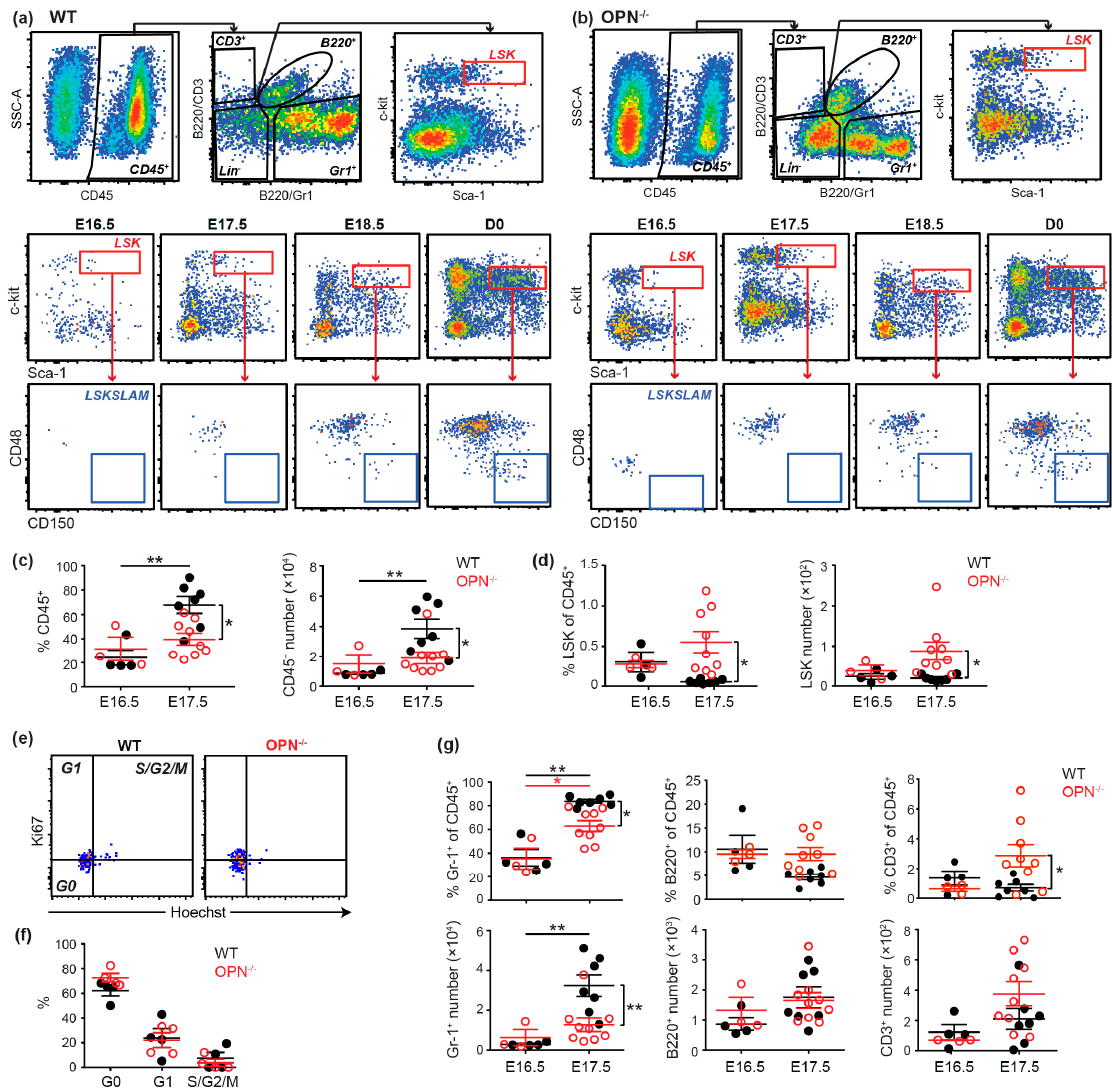
Figure 2. OPN is important in the maintenance of fetal progenitor pools. ( a ) A representative flow cytometric analysis of CD45 + hematopoietic cells, lineage positive cells, LSK progenitors (red gate) and SLAM hematopoietic stem cells (HSC) (blue gate) in fetal BM of wild-type (WT) and ( b ) OPN -/- mice. ( c ) Comparison of incidence and content of CD45 + and ( d ) LSK progenitors in E16.5 and E17.5 fetal BM of WT and OPN -/- mice. ( e ) Representative cell cycle analysis profile with ki67 and Hoechst on E17.5 BM LSK cells (concatenated n = 2 for WT and n = 3 for OPN -/- ) and ( f ) incidence of WT and OPN -/- E17.5 fetal BM cells in G0, G1 and S/G2/M. ( g ) Incidence and content of Gr-1 + granulocytes, CD3 + T-cells and B220 + B-cells in E16.5 and E17.5 fetal BM of WT and OPN -/- mice. Data represent the cell content after normalization using mouse weights. Each dot represents the average value for a litter (for fetal) or an individual mouse from different litters (for newborn). WT: closed black circle; OPN -/- : open red circle; * p < 0.05, ** p < 0.01. Data shows mean ± SEM, n ≥ 3. In contrast, in fetal liver, which is the main reservoir of hematopoietic progenitors and HSC during embryogenesis, no significant differences in the incidence or content of hematopoietic cells (CD45 + ), granulocytes (Gr1 + ) or HSC and progenitors (SLAM and LSK cells) were observed between